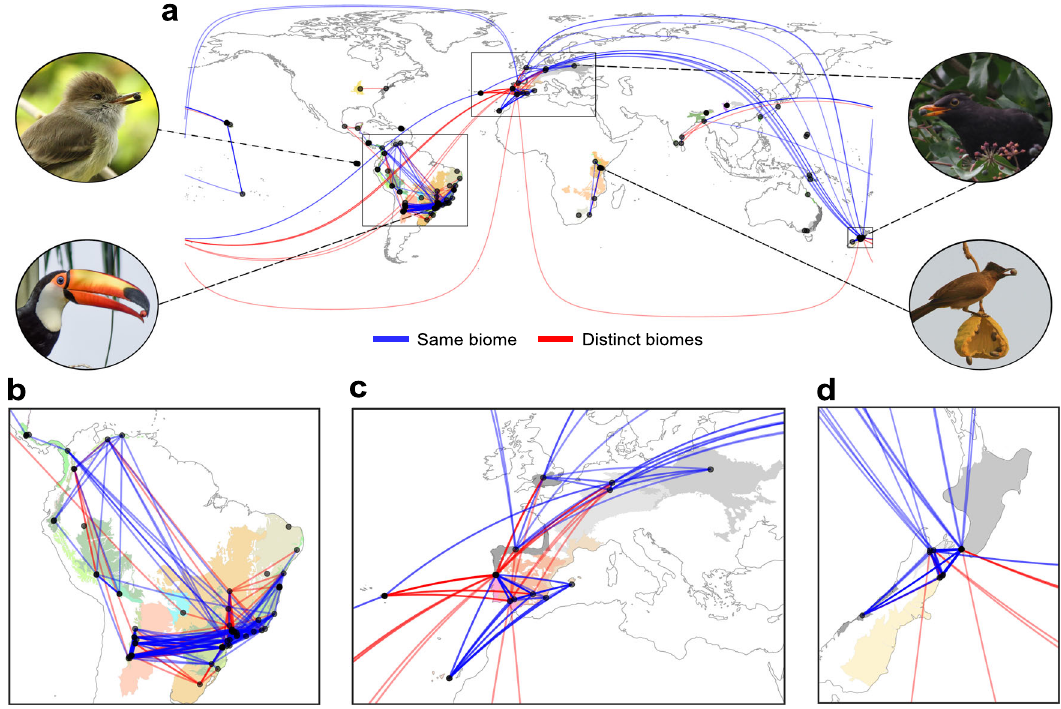
Fig. 2|Plant – frugivoreinteractionssharedamonglocalnetworks,ecoregions, and biomes. a World map with points representing the 196 avian frugivory net- works in our dataset. Colors of shaded areas represent the 67 ecoregions where networkswerelocated,withsimilarcolorsindicatingecoregionsthatbelongtothe same biome. Lines represent the connections (shared interactions) plotted along the great circle distance between networks, with most of these connections occurring within (blue lines) rather than across (red lines) biomes. Stronger color tones of lines indicate higher similarity of interactions (1- β WN ) between networks. Connectionsacrosscontinentsweremostlyattributedtointroducedspeciesinone